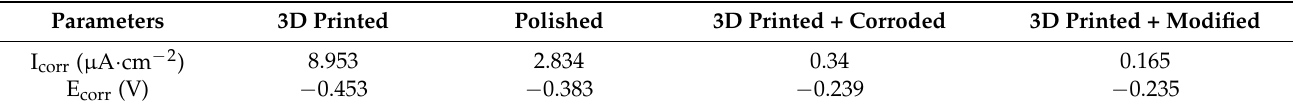
Figure 7. Tafel polarization curves of different samples. Table 1. Corrosion characteristic parameter table of different samples.